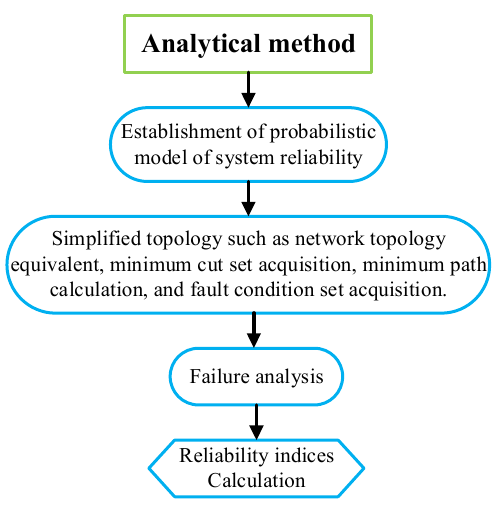
Figure 3. Flow chart of the analytical method.